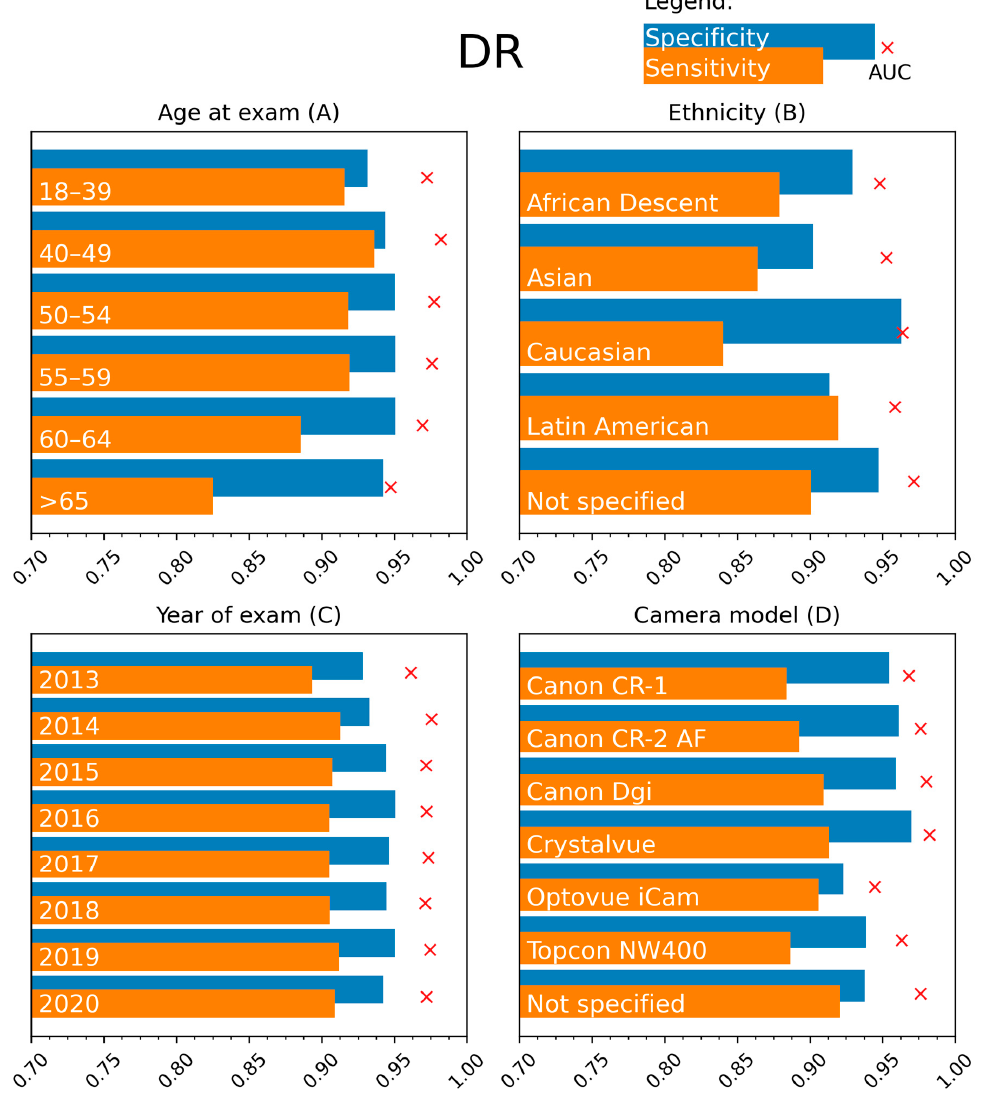
Figure 2. Stratification results: sensitivity (orange), specificity (blue), and AUC (red cross) for detecting referable DR for different subgroups of the test set. The subgroups were created based on presented metadata, namely age at the exam (in years), ethnicity, year of exam, and camera